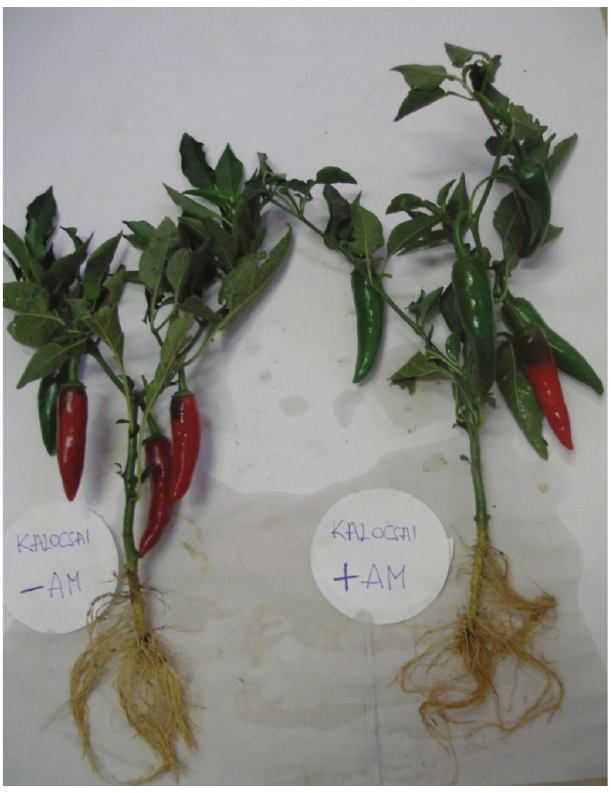
Figure 2. AM-treated and non-treated Capsicum annuum L. var. longum cv.